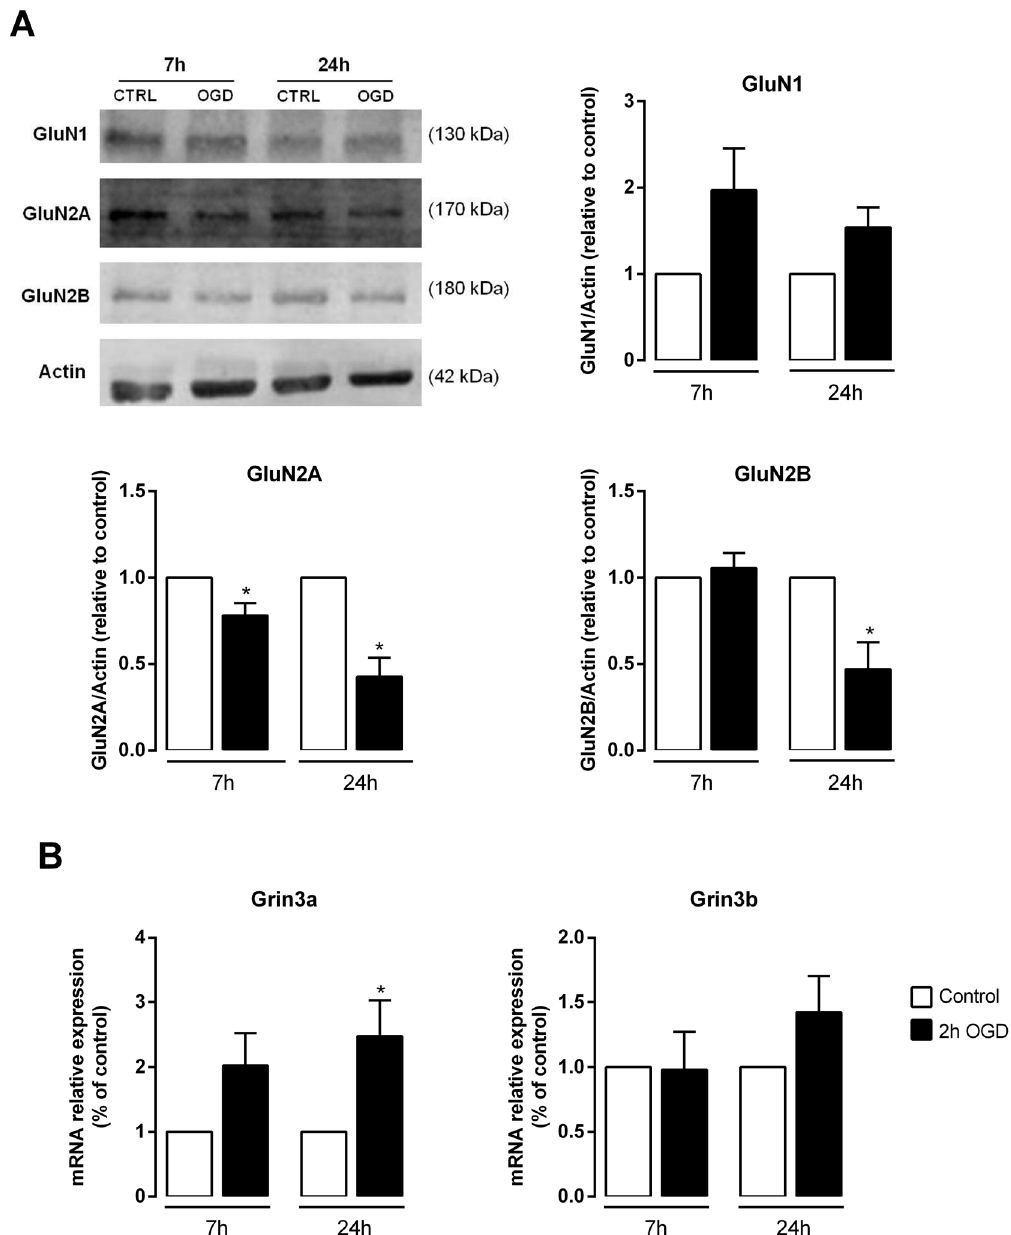
Figure 9. OGD affects the expression levels of NMDAR subunits. ( A ) Total protein extracts were collected 7 h and 24 h after OGD and Western blot analysis was performed. Whereas total GluN1 levels tend to increase after the insult, a decrease in total GluN2A was observed after both periods of recovery while GluN2B decreased at 24 h after the OGD insult. The left panel shows a representative western blot for GluN1, GluN2A and GluN2B levels after OGD. The right panel represents the quantification of the Western blots. Actin was used as loading control. Bars represent the mean 6 SEM of 5–9 independent experiments, performed in distinct preparations. ( B ) OGD induces a marked increase in the mRNA levels of GluN3A but not in GluN3B. Bars represent the mean 6 SEM of 3–5 independent experiments, performed in distinct preparations. * p , 0.05, as determined by the Student’s t -test.